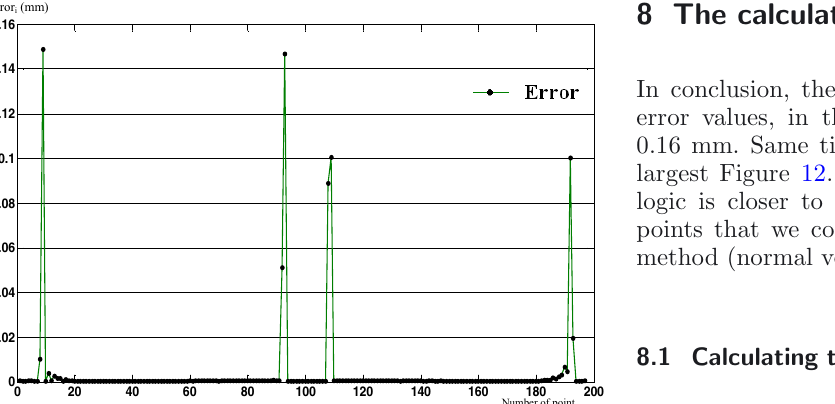
Fig. 12. (Color online) Errors of from on the tooth in mm.